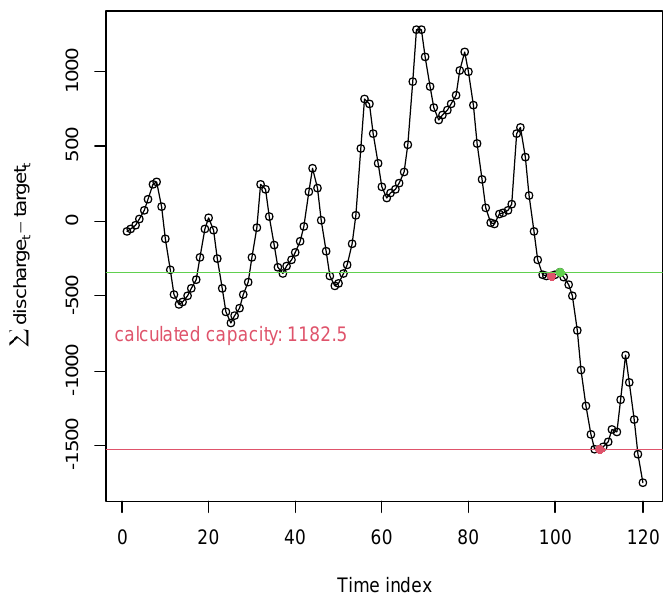
Figure 6. Diagram of Rippl ’ s method for no-fail storage volume of the Bukan reservoir. For annually averaged 1472 × 10 6 m 3 of inflow and 1645 × 10 6 m 3 of the target, the rippl function computes the reservoir capacity as 1181.2 × 10 6 m 3 and plots the results as shown in Figure